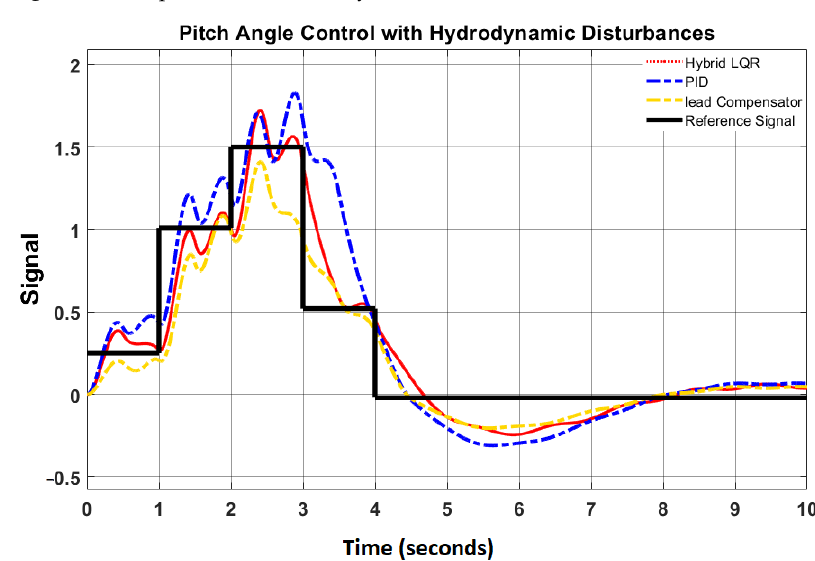
Figure 13. Pitching angle control system with hydrodynamic disturbances.